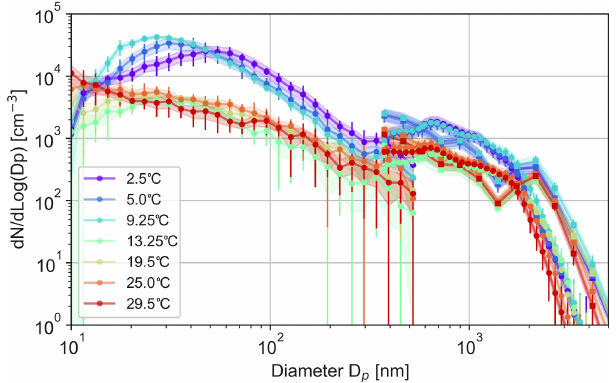
Figure 7. Aerosol size distributions for 0.1M NaCl solution bub- bled at 0.8Lmin − 1 , as measured with the DMPS (circles), OPS (rectangles), and APS (circles) for different water temperatures. During the experiments ( ∼ 30min each), water temperature was ris- ing or falling by 1–2 ◦ max, depending on the relation between water and room temperatures. Legend presents mean temperature for each